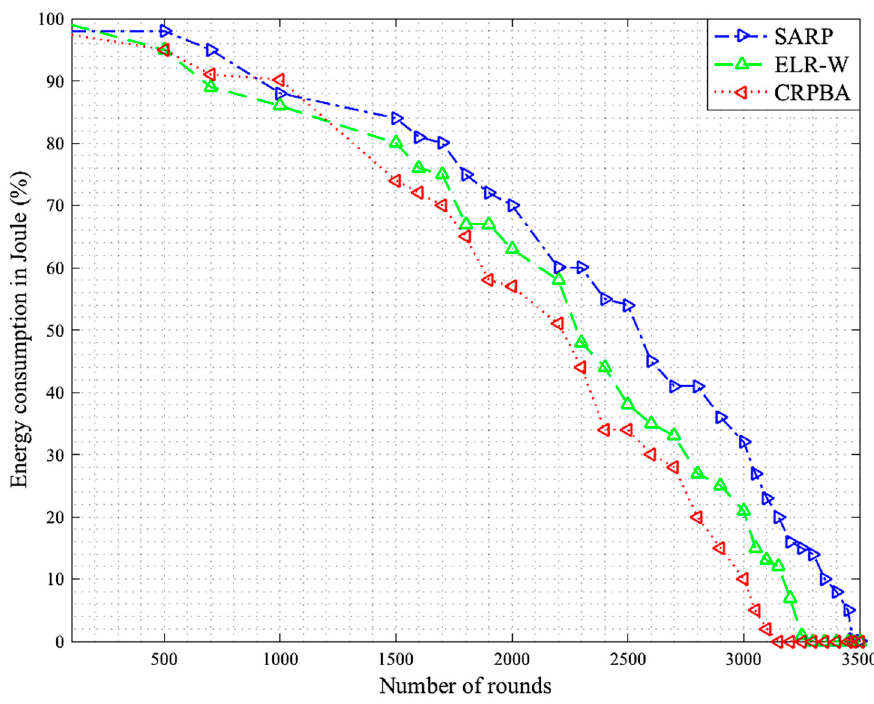
Figure 6. Residual energy vs number of rounds.